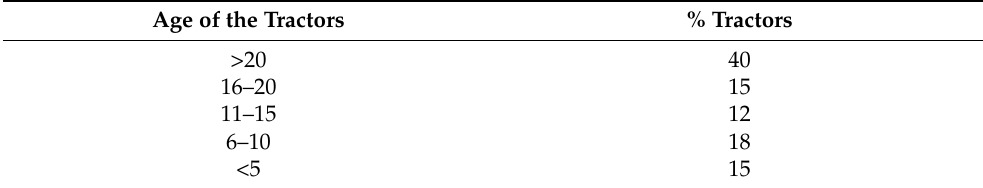
Table 1. Percentage of tractors by age